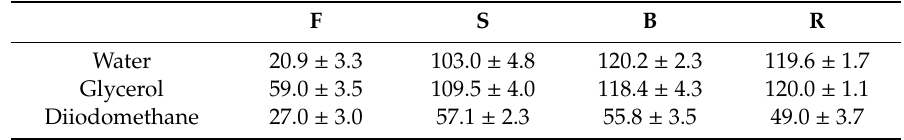
Table 3. Contact angles obtained on unprinted papers.